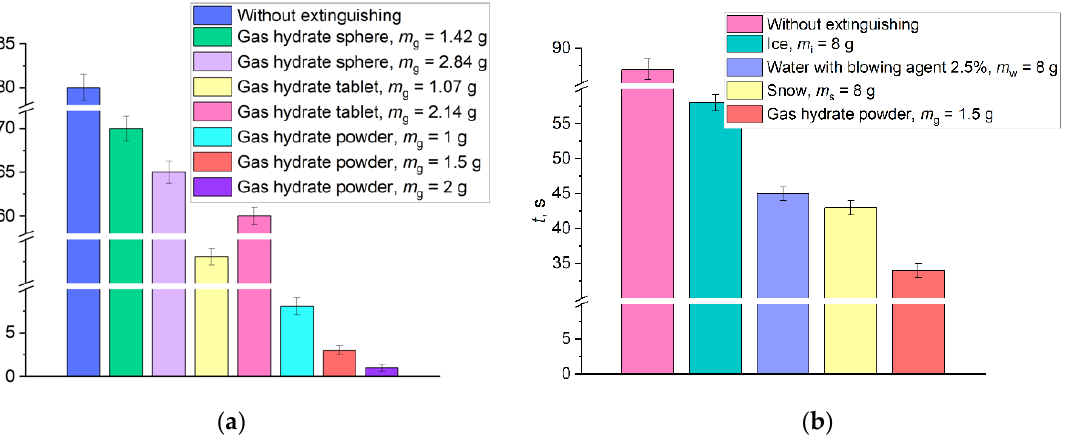
Figure 8. Extinction times of a gasoline pool fire ( V 0 ≈ 3 mL) without extinguishing and when suppressed by ( a ) CO 2 hydrate in the form of powder, tablets, and spheres with varying initial mass m g , and ( b ) ice and water with 2.5% of foaming agent, snow, and CO 2 hydrate powder.